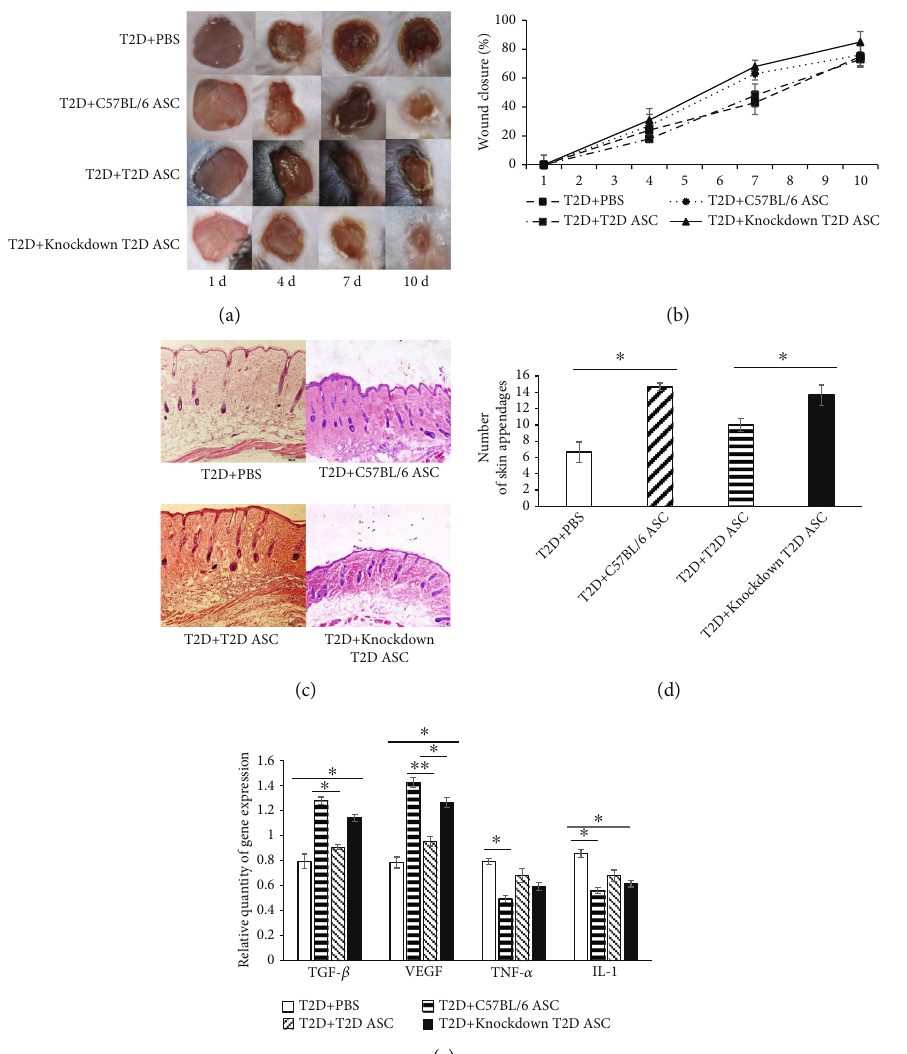
Figure 6: E ff ects of Adra2a knocked-down T2D ASCs on wound healing in T2D mice. (a) Macroscopic pictures of representative wounds of T2D mice treated with PBS, C57BL/6 ASCs, T2D ASCs, and Adra2a knocked-down T2D ASCs (namely, T2D+PBS; T2D+C57BL/6 ASC; T2D+T2D ASC; T2D+knocked-down T2D ASC groups, respectively, same as below) on day 1, 4, 7, and 10 after wounding. (b) Graphical summary of changes in wound area expressed relative to the initial size of the wound at day 1. Data are mean ± SD . (c) H&E staining of wound sections of T2D mice treated with PBS, C57BL/6 ASCs, T2D ASCs, and Adra2a knocked-down T2D ASCs 14 days postwounding. (d) Statistics of the number of hair follicles around the wound in the skin of T2D mice. (e) The expression of VEGF, TGF- β , TNF- α , and IL-1in the tissue of the wound area treated with PBS, C57BL/6 ASCs, T2D ASCs, and Adra2a knocked-down T2D ASCs on the 14th